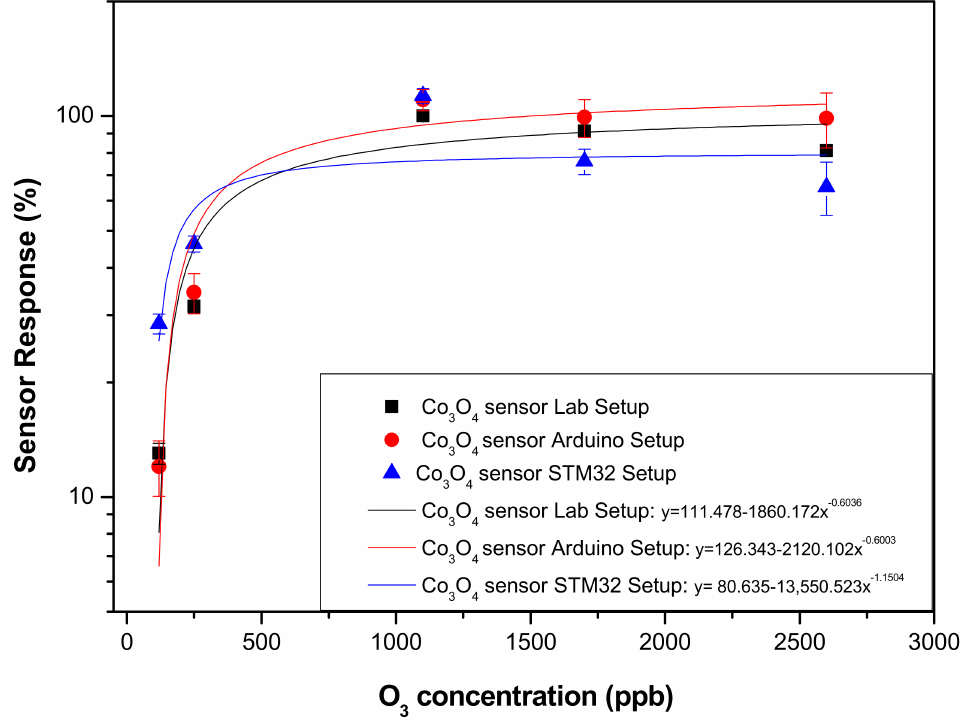
Figure 7. Sensor Response (%) of Co 3 O 4 film measured by 3 different setups under exposure to 120–2600 ppb O 3 , at room